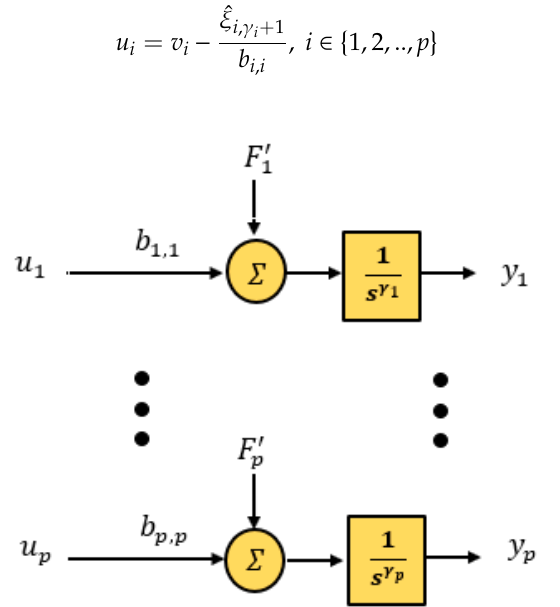
Appl. Sci. 2020 , 10 , x FOR PEER REVIEW Figure 4. Generalized disturbance representation for the decentralized ADRC scheme.